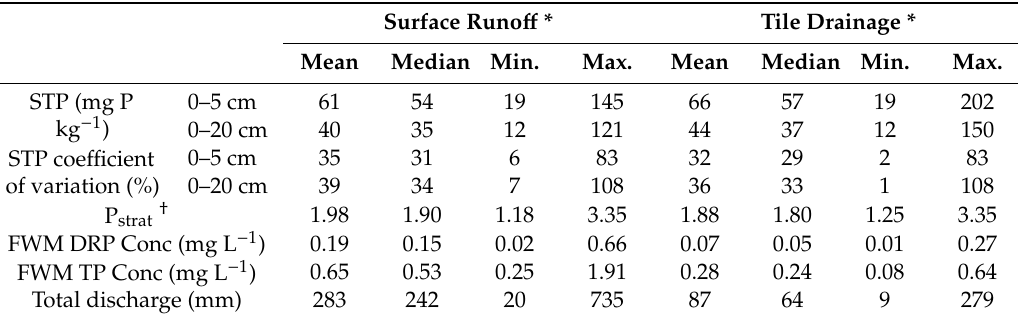
Table 1. Soil test P (STP) concentrations and P stratification ratios (P strat ) across soil sampling events at 39 fields, and edge-of-field discharge and dissolved reactive P (DRP) and total P (TP) flow weighted mean (FWM) concentrations during the relevant sampling windows.